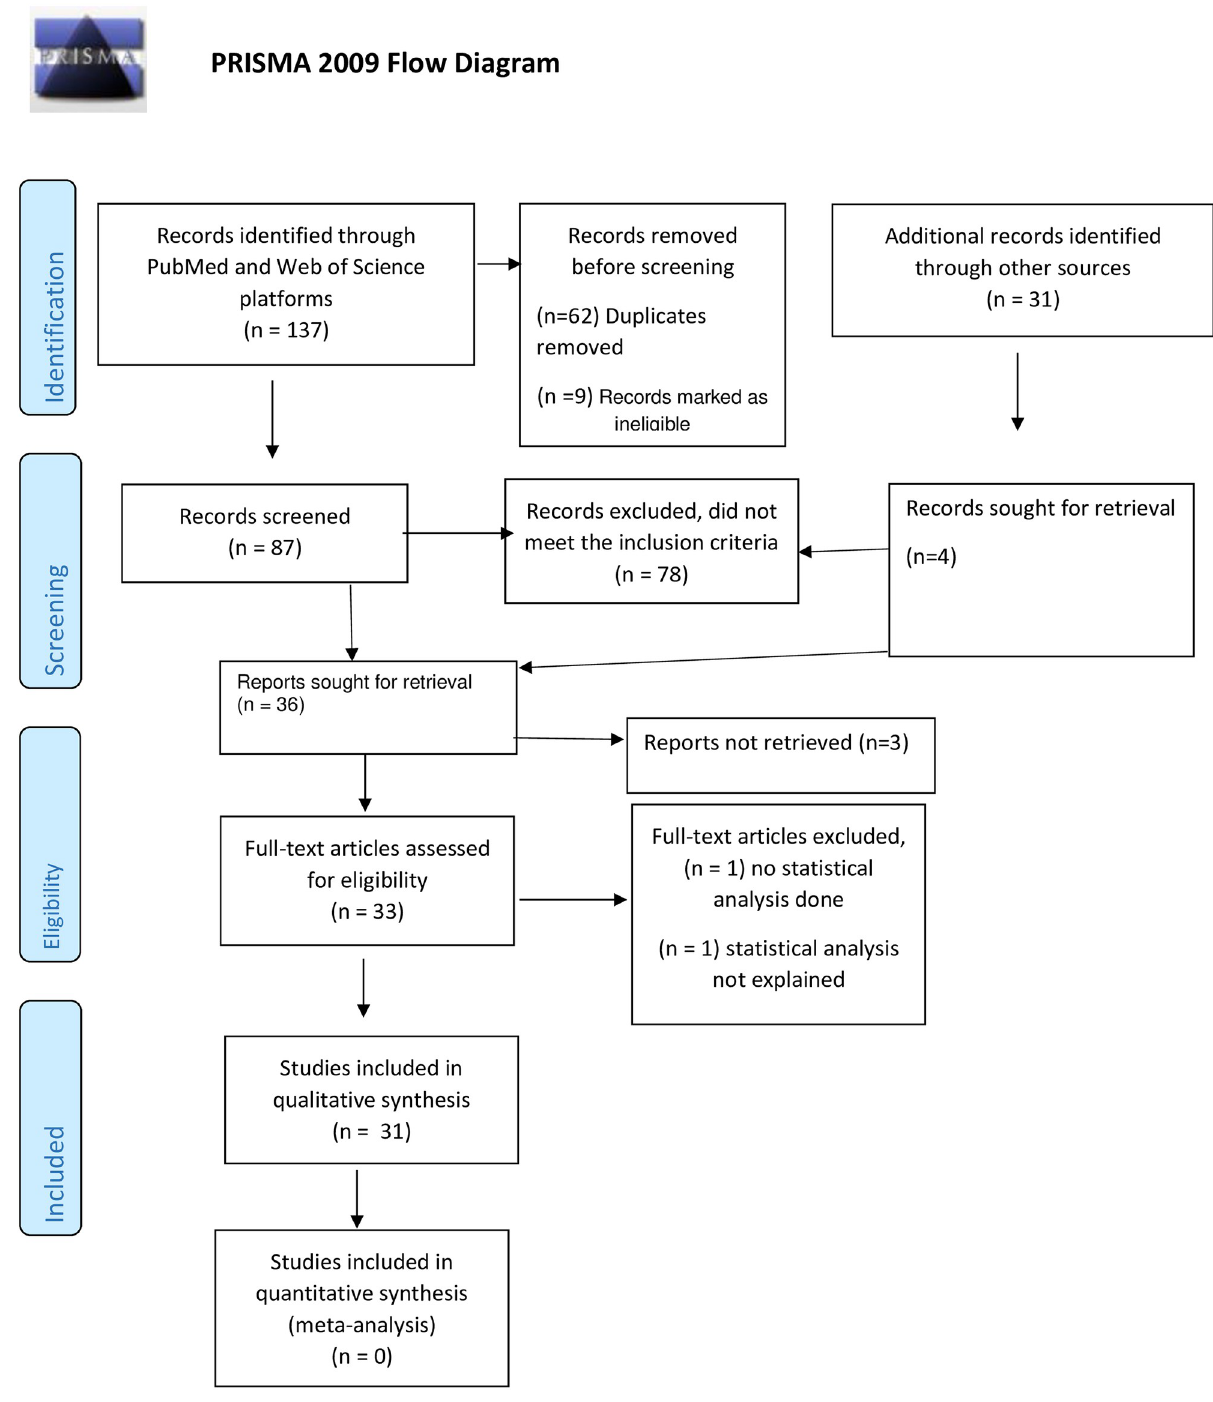
Fig 2. PRISMA flow chart [13].